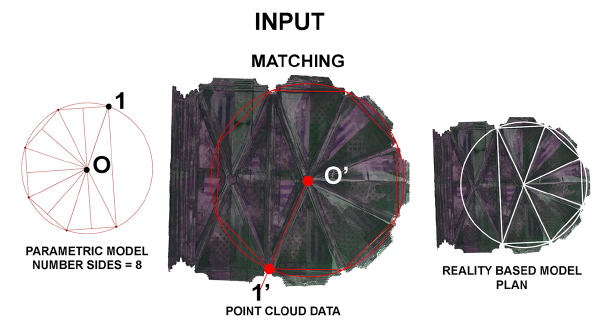
Figure 16 . Church of Donnaregina apses vault: matching the adaptive model on point cloud.